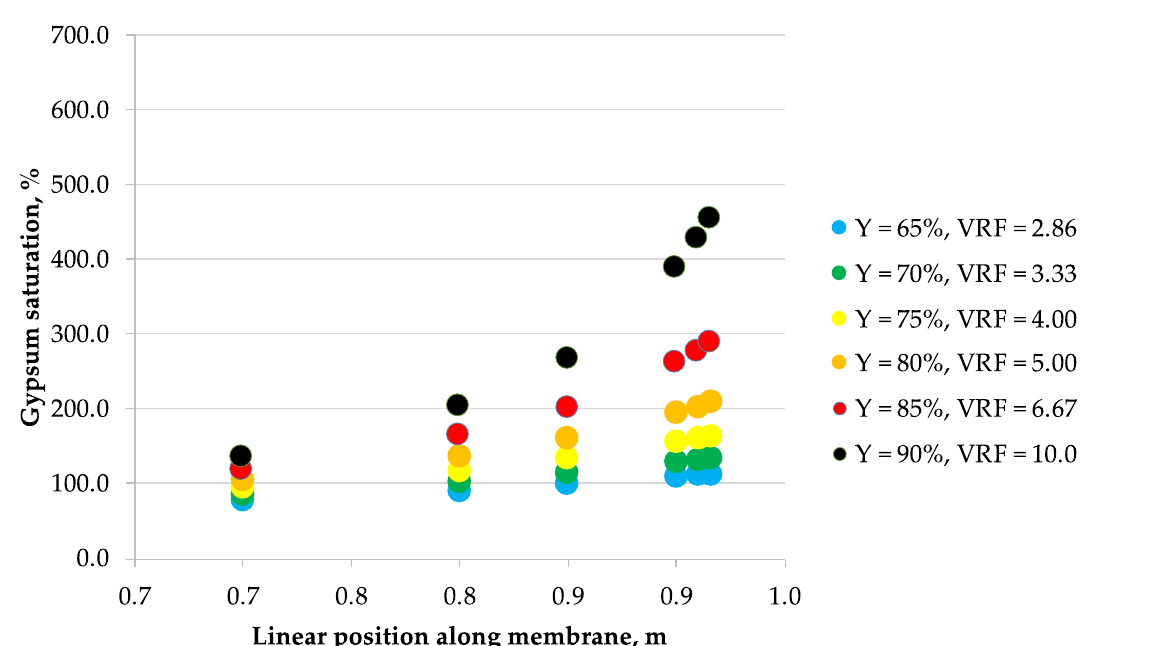
Figure 3. Saturation vs. position along the membrane for mine water B (33.2 g/L as Cl − , 0.937 g/L as SO 42 − , 19.5 g/L as Na + , 0.990 g/L as Mg 2+ , 0.771 g/L as Ca 2+ ) and NF270 nanofiltration membrane.